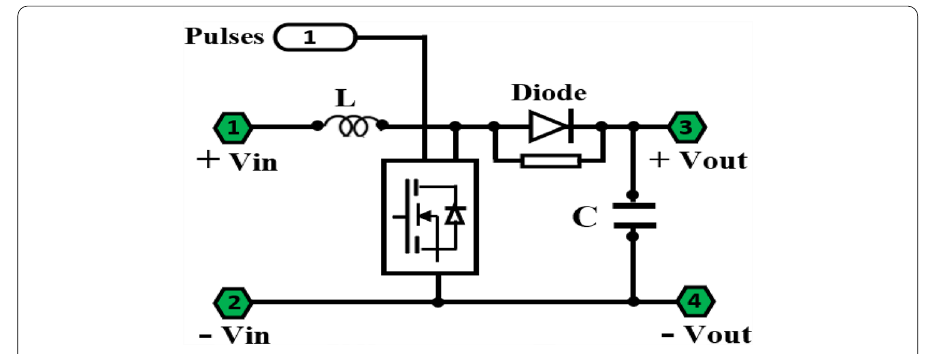
Fig. 5 Simulink model of the boost